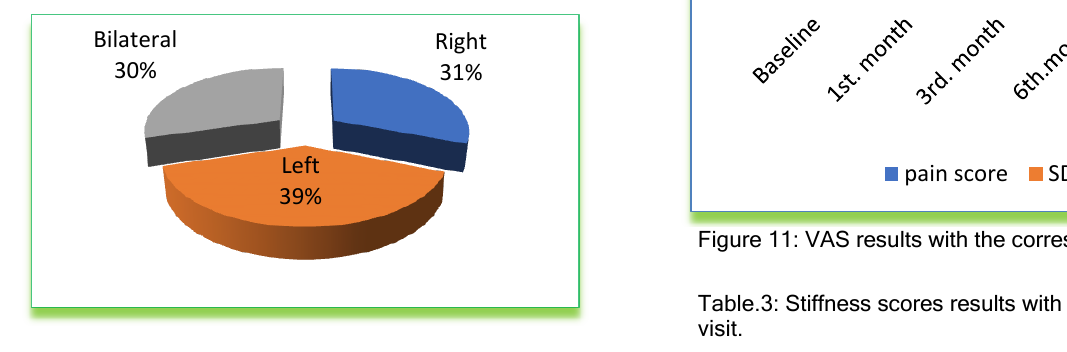
Figure 8: The patients demographic data.